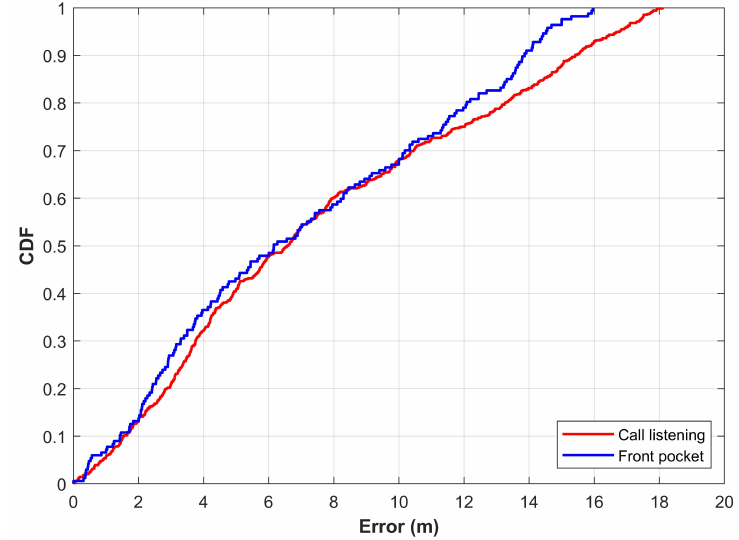
Figure 14. CDF graph for ’call listening’ and ’front pocket’